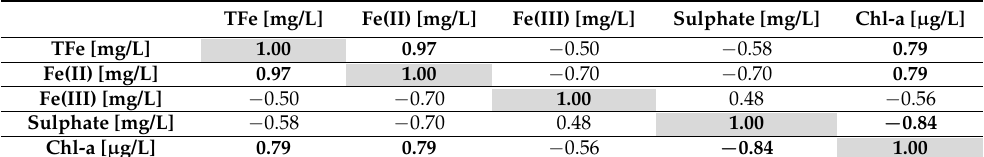
Table 2. Correlations matrix with the recorded in situ water parameters: TFe, Fe(II), Fe(III), sulphate and Chl-a.